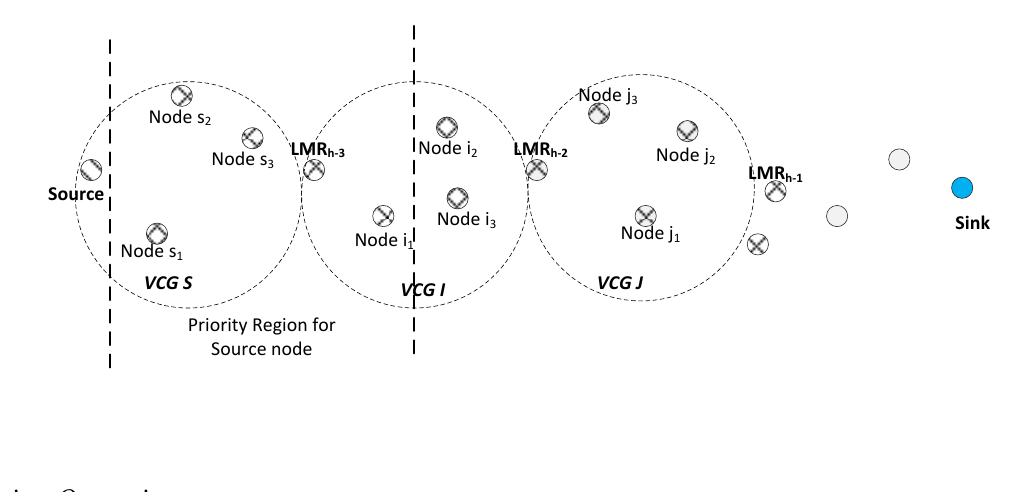
Figure 7. Illustration of the routing